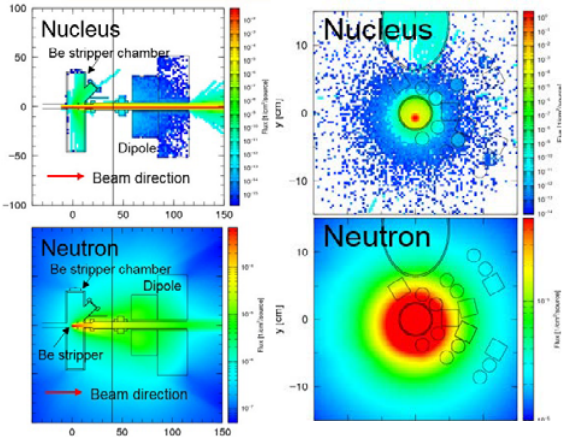
Figure 2 : Fluence Distribution of nucleus (up) and neutrons (down) at stripping reaction area.